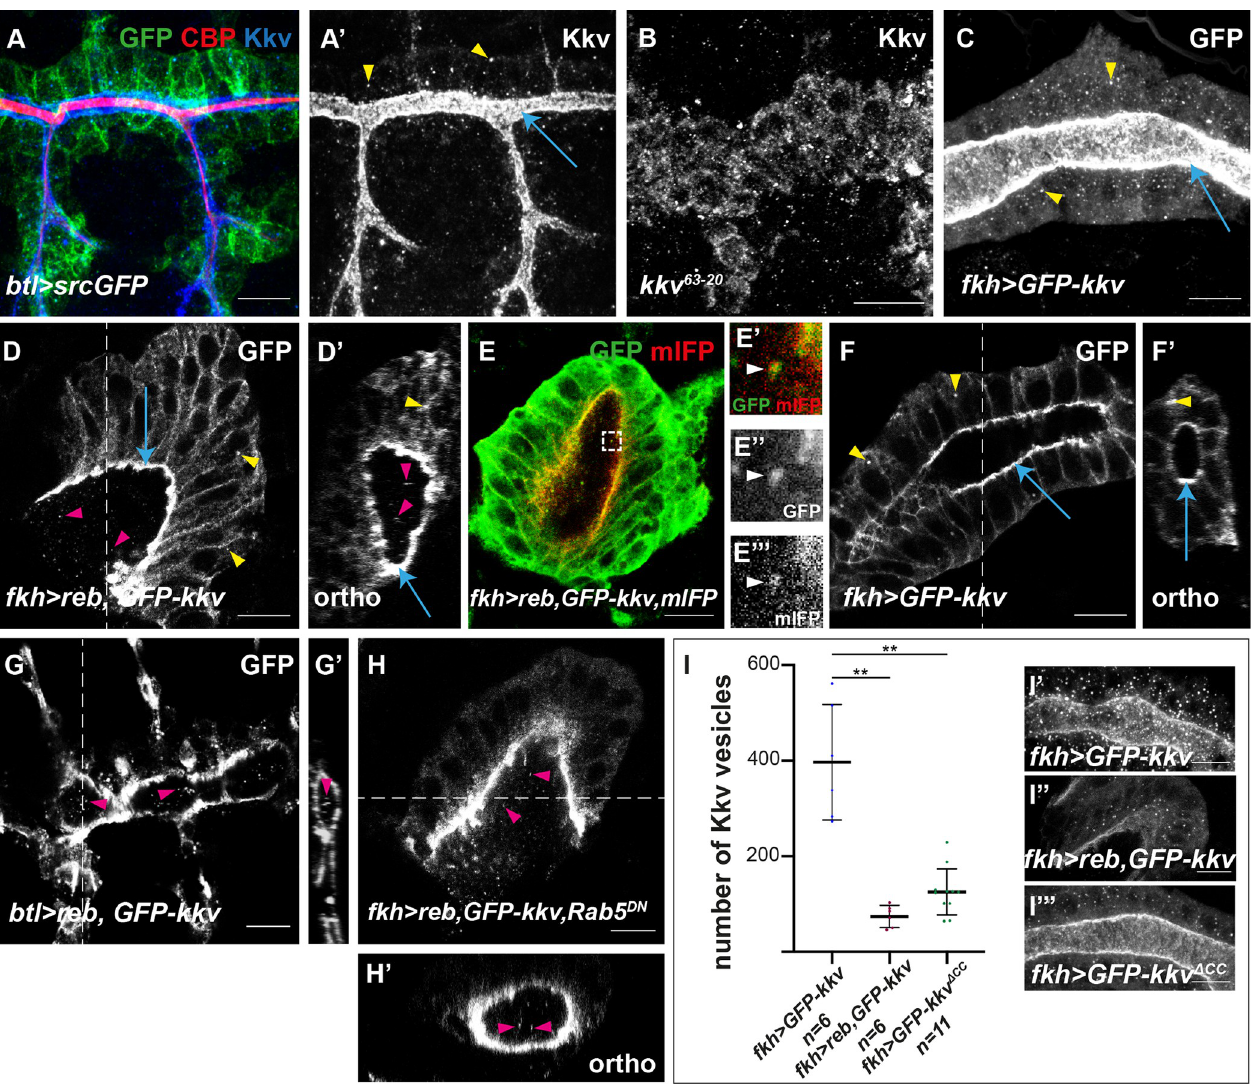
Fig 5. Analysis of Kkv trafficking. All images are single confocal sections except A - C , which are projections of confocal sections. ( A , A’ ) In trachea of wild- type embryos, Kkv is present in the apical region (blue arrows) and in intracellular vesicles (yellow arrowheads). ( B ) In kkv mutants unable to polymerise chitin, Kkv is not properly localised. ( C ) GFP-Kkv localises to the apical region (blue arrows) and in intracellular vesicles (yellow arrowheads). ( D ) When reb and GFP-kkv are coexpressed in salivary glands, Kkv is present in the apical membrane (blue arrow), in intracellular vesicles (yellow arrowhead), and also in punctae in the lumen (pink arrowheads). This is clearly observed in orthogonal sections ( D’ ). ( E ) These luminal punctae corresponded to membranous structures. ( F , F’ ) In contrast, when GFP-kkv is expressed alone, luminal punctae are absent, and Kkv is only found apically (blue arrow) and in intracellular vesicles (yellow arrowhead). ( G ) Luminal punctae (pink arrowheads) are also observed in the trachea of embryos overexpressing reb and GFP-kkv . ( H ) When endocytosis is prevented, the coexpression of reb and GFP-kkv in salivary glands still leads to formation of Kkv luminal punctae (pink arrowheads). ( I ) Quantifications of the number of intracellular Kkv vesicles in salivary glands when expressing GFP-kkv ( I’ ), reb and GFP-kkv ( I” ), and GFP-kkv Δ CC . n is the number of salivary glands analysed. The underlying data for quantifications can be found in the S1 Data. Scale bars: 10 μ m.